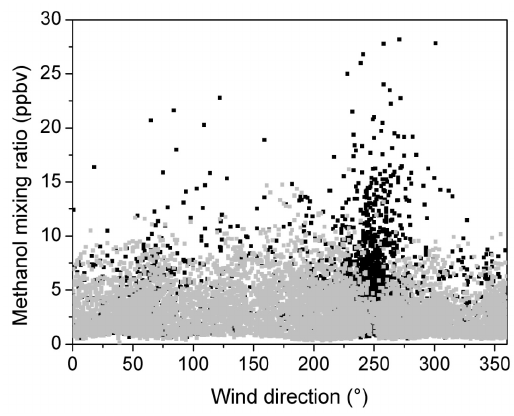
Fig. 1. The black points represent the methanol flux data (2009– 2010) deleted by the monoterpenes variance filtering. The light grey points represent the data that succeed the test.